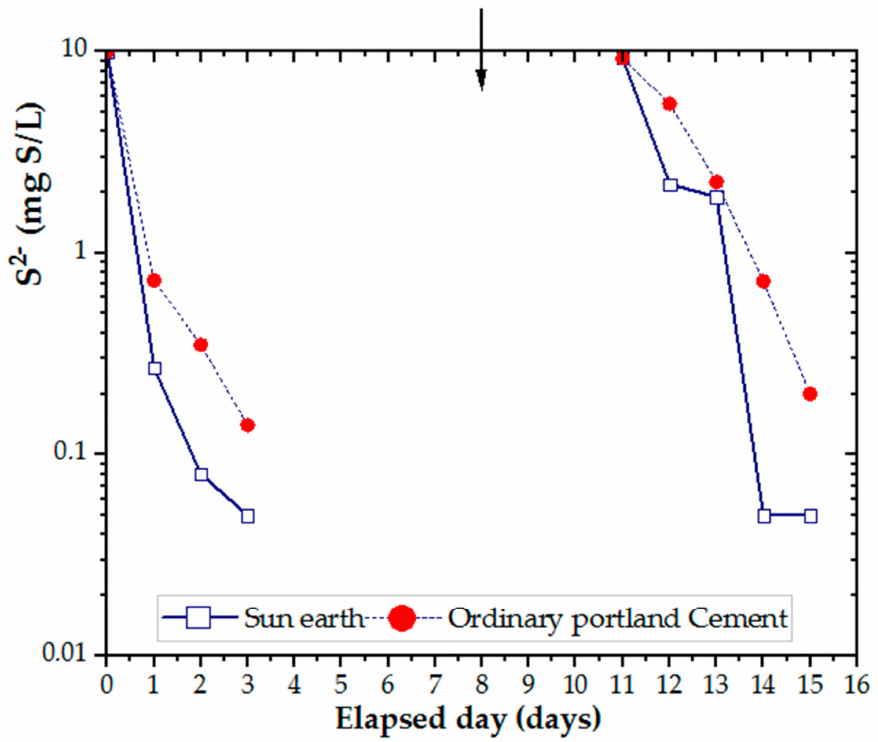
Figure 5. Efficiency of OPC and San-Earth materials in H 2 S adsorption. Arrow ( ↓ ) indicates the addition of sodium